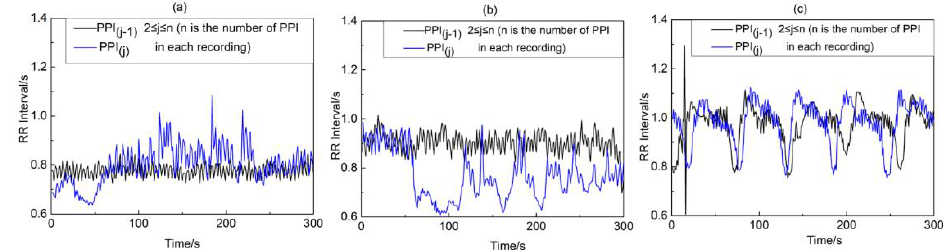
Figure 5. Adjacent PPI segments of ( a ) normal subject, ( b ) mild – moderate and ( c ) severe OSA subject.